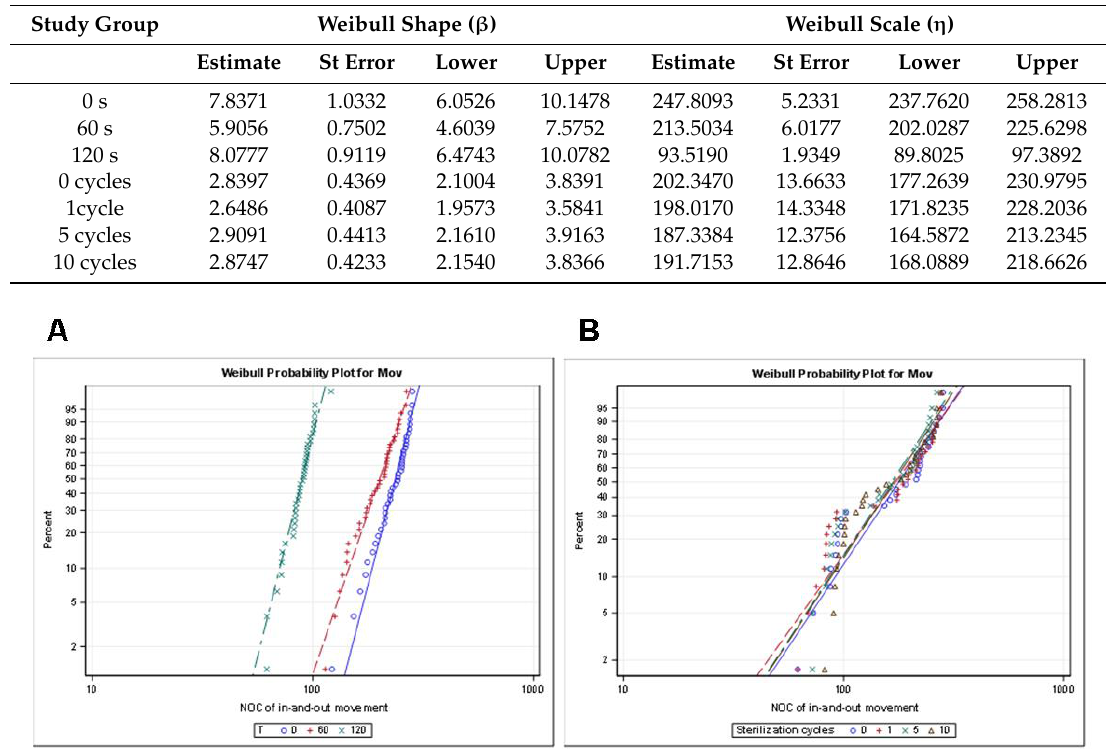
Table 6. Weibull statistics of the number of cycles of in-and-out movements for the time of use and sterilization cycles study groups.